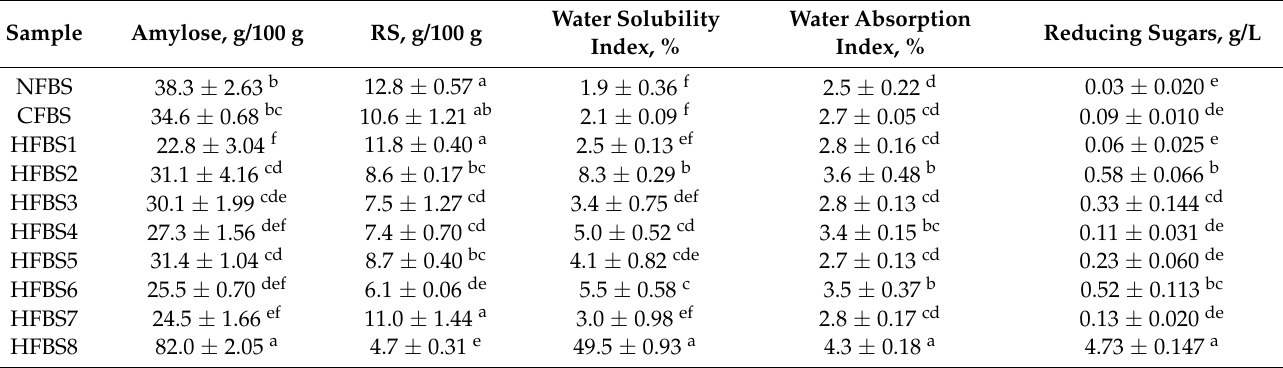
Table 1. Physicochemical characterization of native and hydrolyzed faba bean starches 1 .